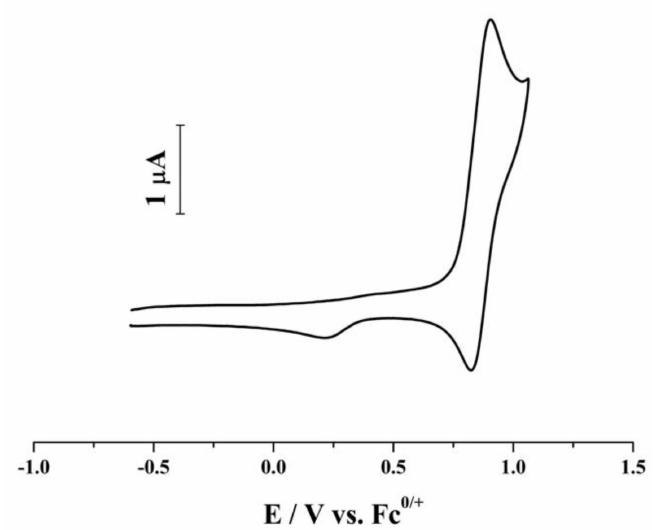
Figure 5. Cyclic voltammograms obtained for 5 mM 1 in [bmim][BF 4 ] containing 200 ± 10 ppm water